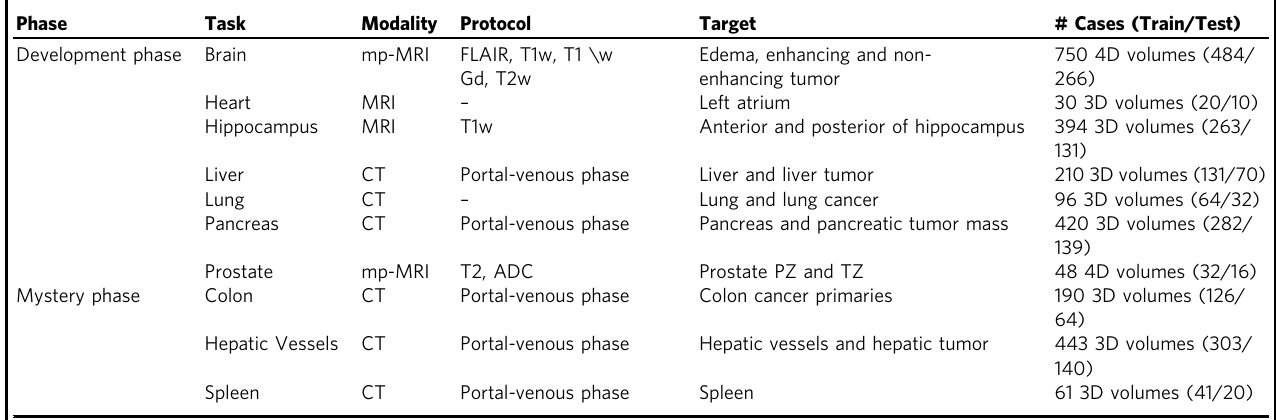
Table 2 Summary of the ten data sets of the Medical Segmentation